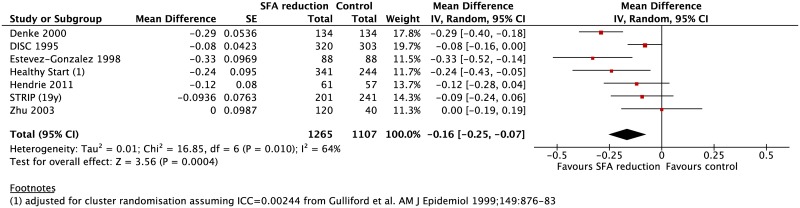
Meta-analysis of weighted mean (95% CI) differences in effects on total cholesterol (mmol/l) in randomised trials that compared usual diets with reduced saturated fat diets in children.